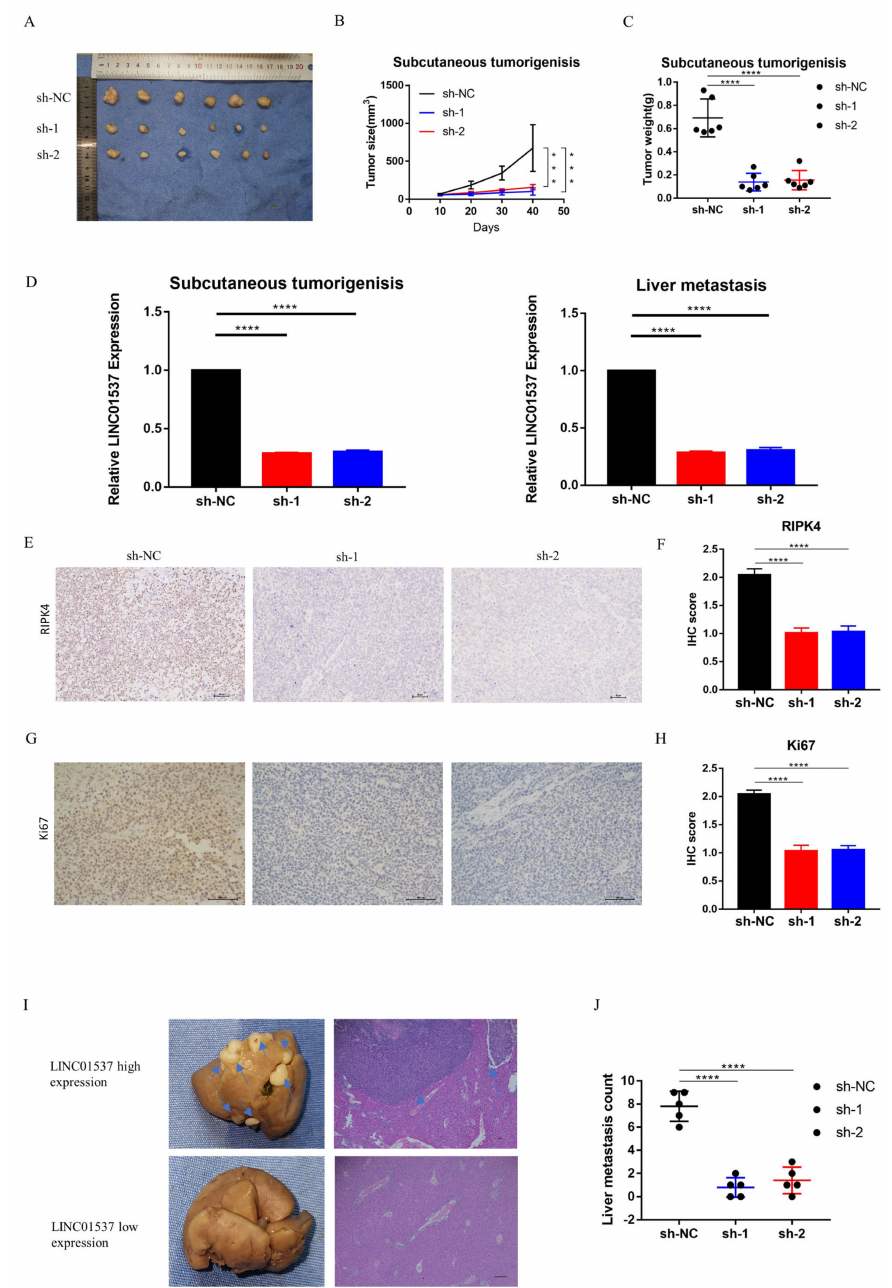
Figure 3. LINC01537 promotes the tumor growth and metastasis of GC in vivo. BGC cells transfected with shRNA (NC: negative control; sh-1: sh-LINC01537-01; sh-2: sh-LINC01537-02) were injected